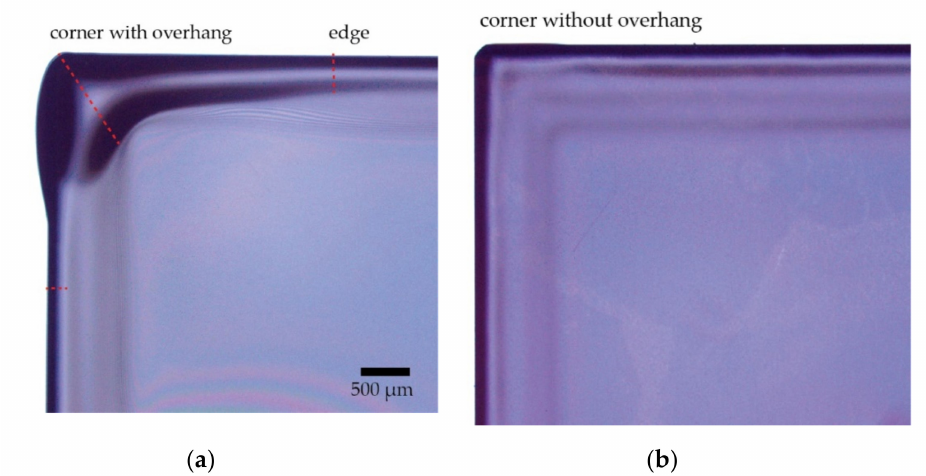
Figure 3. Samples spin-coated with OiR 908-35 resist at 2000 rpm for a target thickness of 5 µ m. ( a ) Using a conventional chuck. A thick edge bead region is clearly visible. The measurements have been made along the red dashed lines. ( b ) Using the custom chuck. The edge bead is visibly reduced. The corner shown was in contact with the spinning chuck.